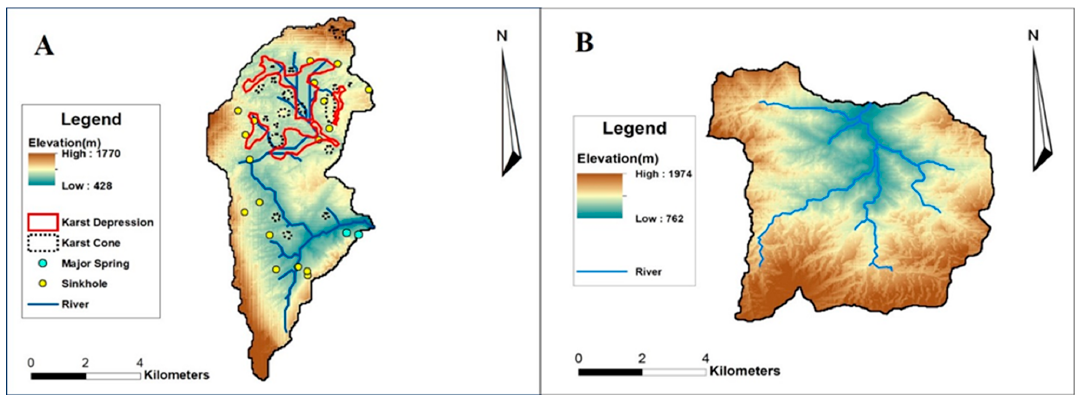
Figure 3. SRTM DEM data (30 × 30 m) for Miaogou ( A ) and Gaojiaping ( B ) watersheds (source: https://earthexplorer.usgs.gov/).